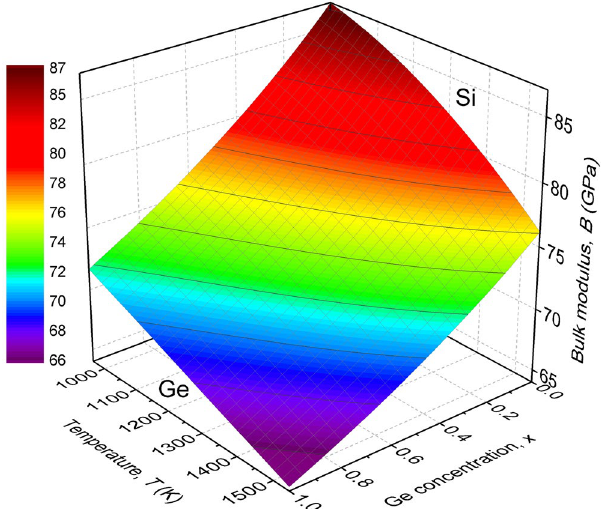
Figure 1. 3D surface plot of the bulk modulus of Si 1 − x Ge x alloys as a function of temperature and Ge concentration, calculated from Eq.